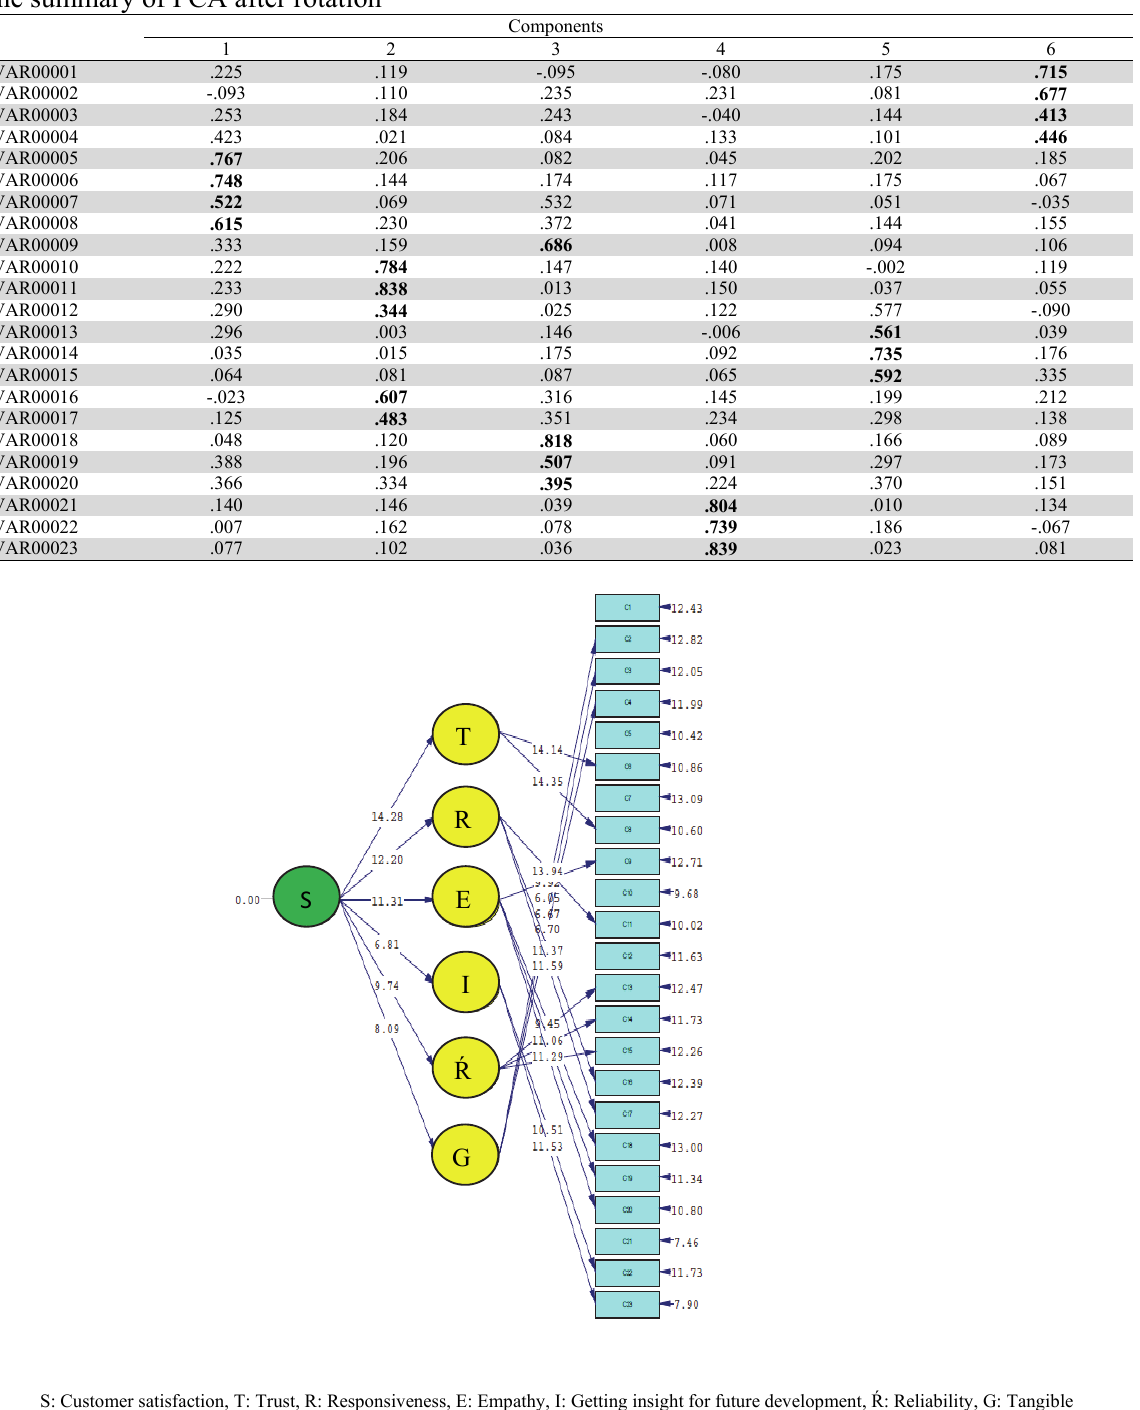
Fig. 2. The results of t-values of the structural equation modeling on the effects of six variables on customer